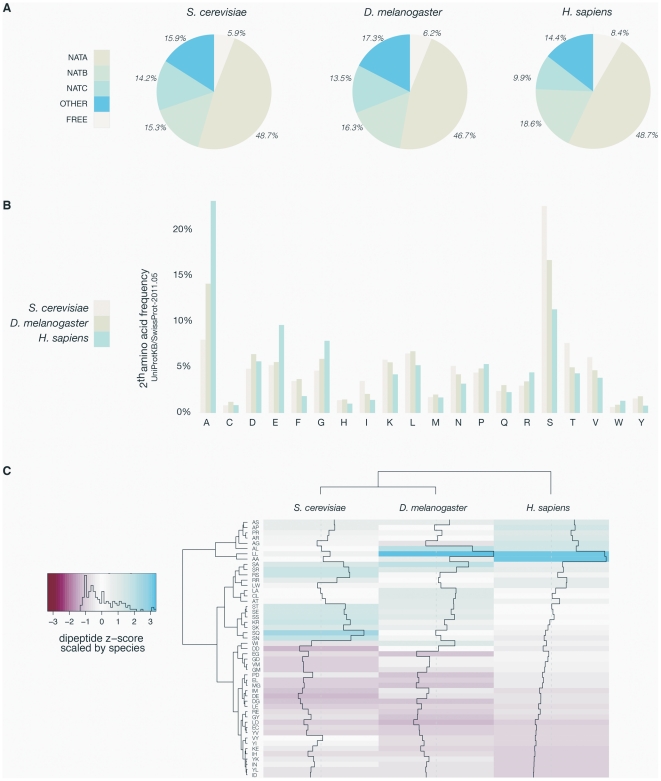
Overview of yeast, fruit fly, and human N-termini in NAT-classes and amino acid prevalence.A. Comparative analyses of the distribution of all methionine-starting yeast (6561), fruit fly (3120) and human SwissProt entries (20238) (SwissProt version 2011-05) according to their Nat-type. For simplicity, methionine processing was assumed to occur for (M)A-, (M)S-, (M)T-, (M)V-, (M)C-, (M)G- and (M)P- starting N-termini, while the X-P- rule was used to assign unacetylated database entries [32]. B. Bar charts of the amino acid occurrence at position 2 of yeast, fruit fly and human SwissProt protein entries. C. Heatmap of the ten highest and lowest ranking dipeptide z-scores across H. sapiens, D. melanogaster and S. cerevisiae. Z-scores are scaled by species, with the highest and lowest ranking z-score colored with the same intensity in blue and red respectively. The species (X-axis) and the dipeptides (Y-axis) were grouped by hierarchical clustering using the euclidian distance matrix of the z-scores.